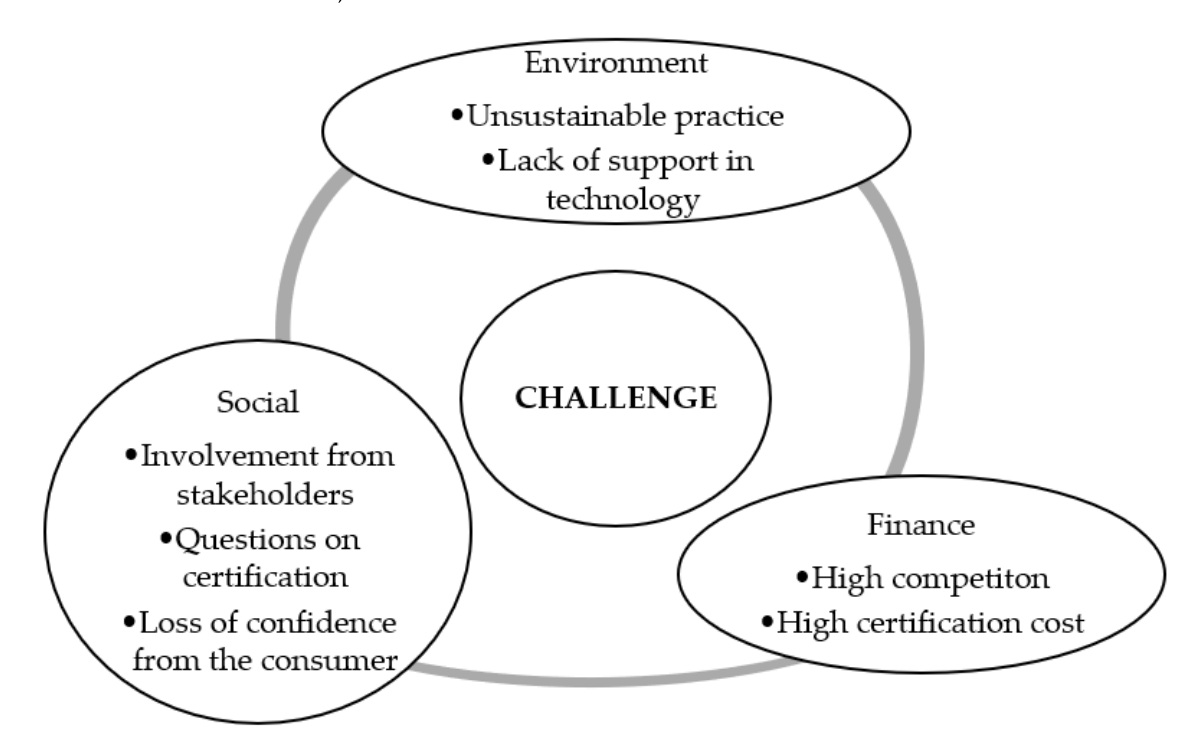
Figure 3. Challenges faced by small scale companies in aquaculture sector.